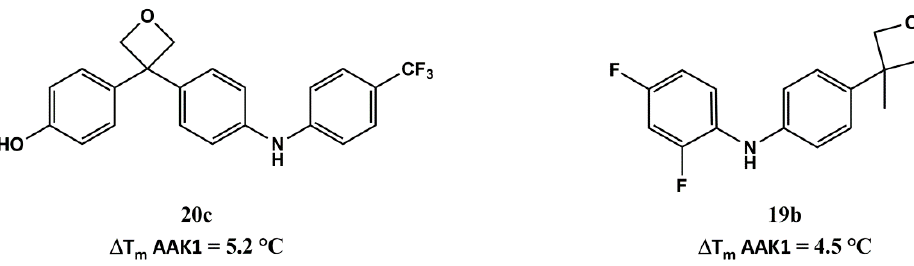
Figure 7. ∆ Tm values obtained for the AAK1 AP2-associated protein kinase 1.